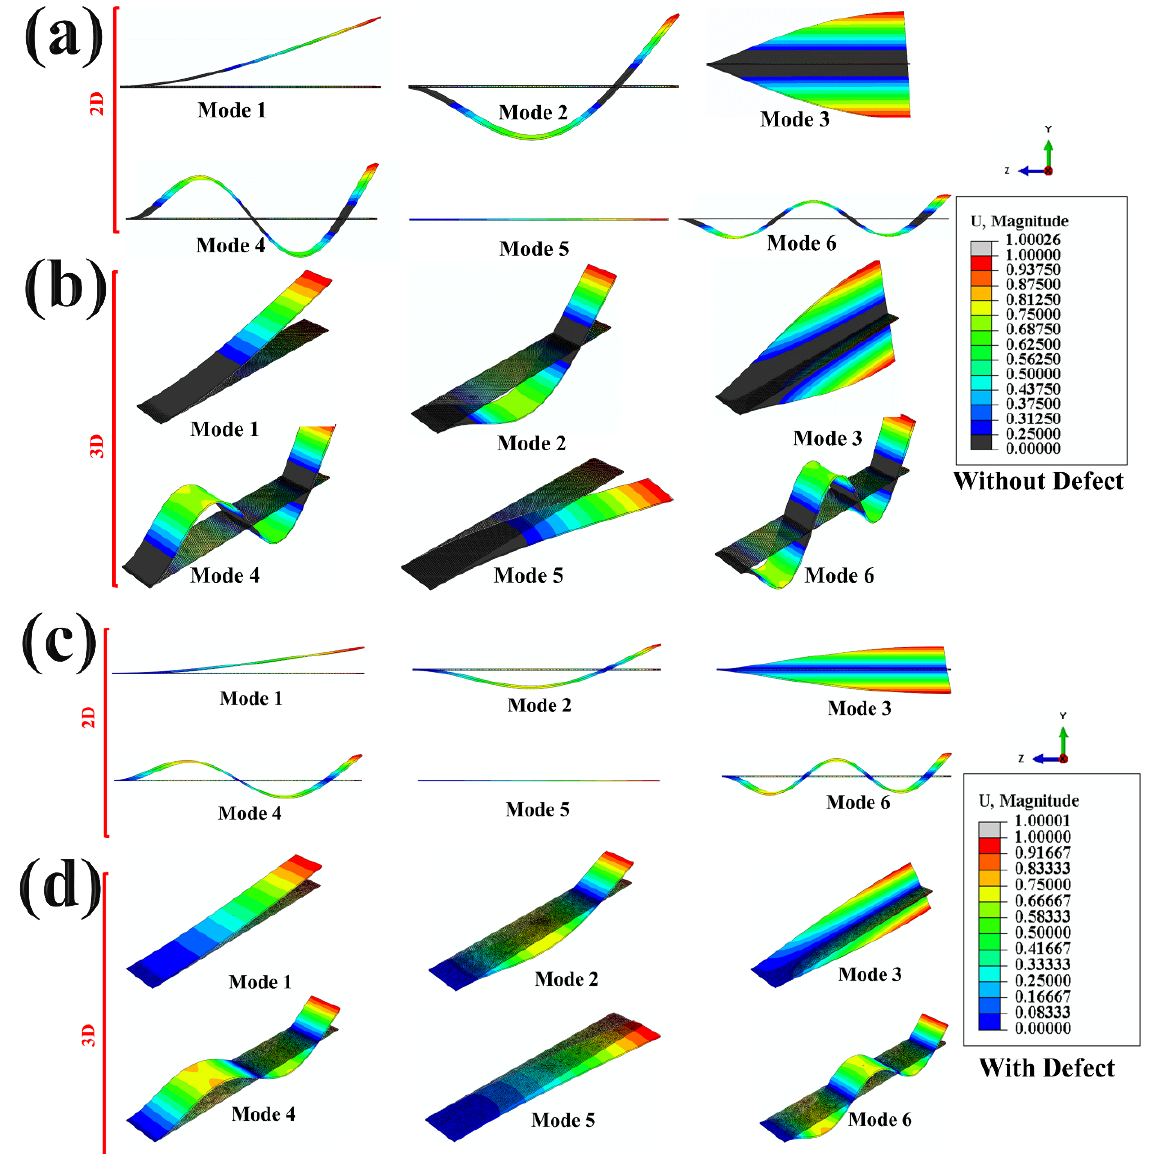
Figure 8. Modal shapes obtained through FEM (Abaqus 6.12) simulation. ( a , b ) 2D and 3D mode shapes of all frequencies for without defect (hole); ( c , d ) 2D and 3D mode shapes of all frequencies with defect (hole).